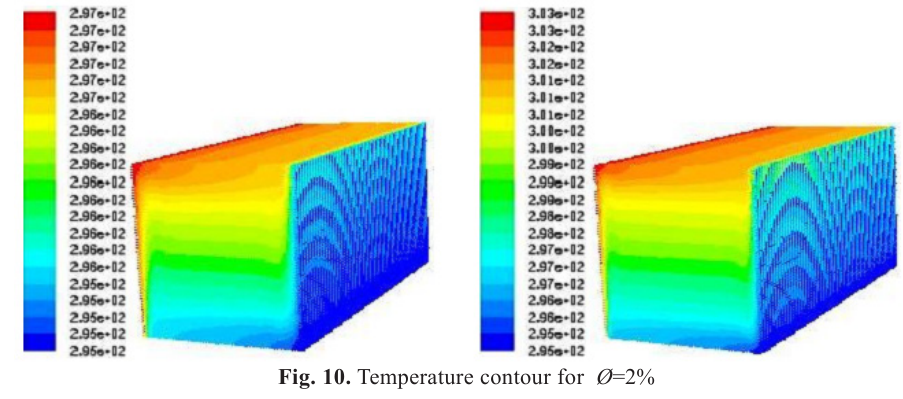
Fig. 10. Temperature contour for Ø =2%